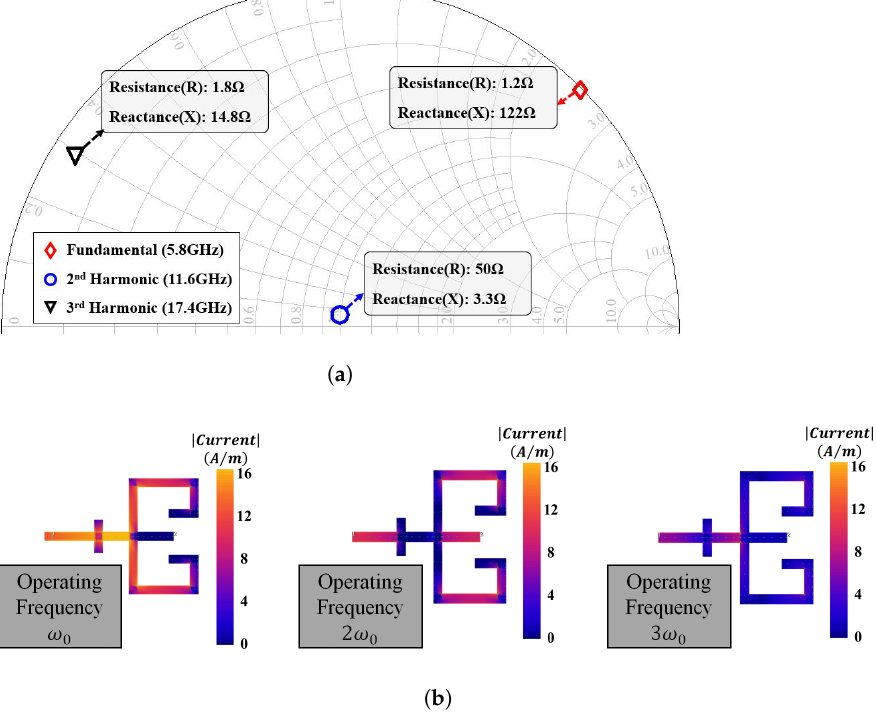
Figure 5. Characteristics of the designed HT filter; ( a ) the input impedance according to harmonics and ( b ) E-field according to